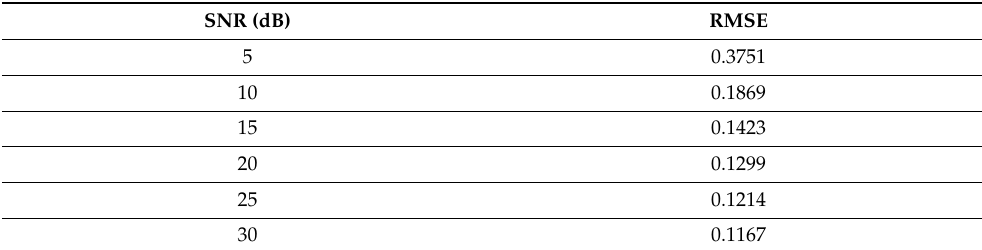
Table 3. RMSE versus SNR with T 60 = 200 ms.